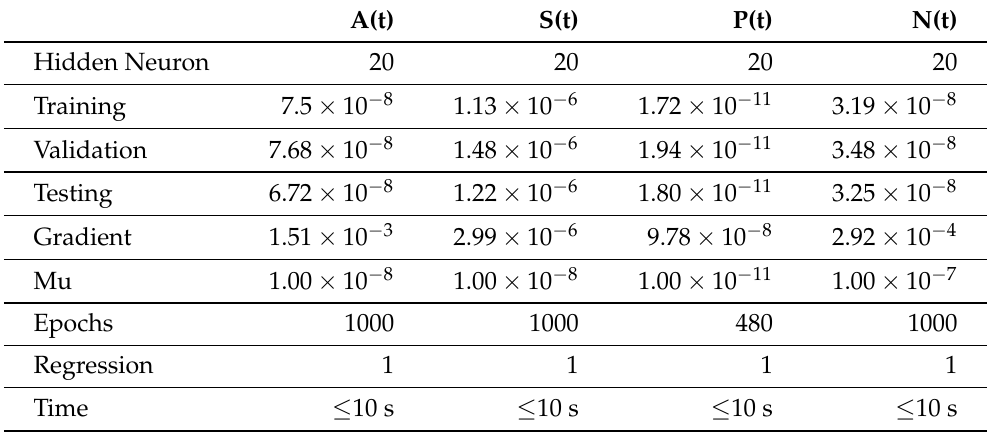
Table 3. Gradient, MSE, number of iterations, mu, and time spent by the computing system to get solutions for Case